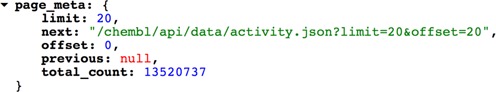
ChEMBL web service page_meta section from a request to https://www.ebi.ac.uk/chembl/api/data/activity.json.